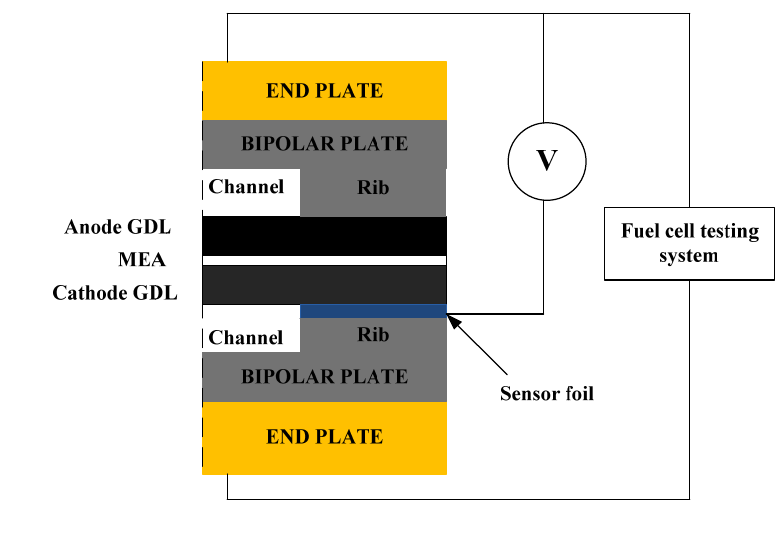
Figure 3. Cross-section of the test single